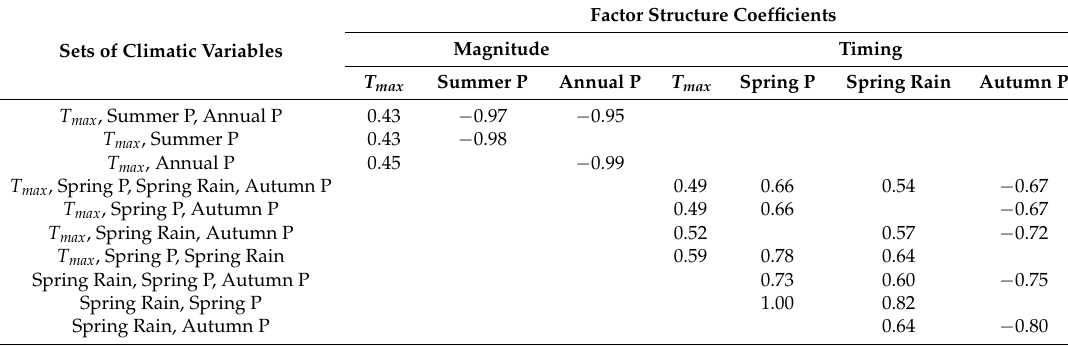
Table A1. Canonical factor structure coefficients of climate variables in the UHR watershed.